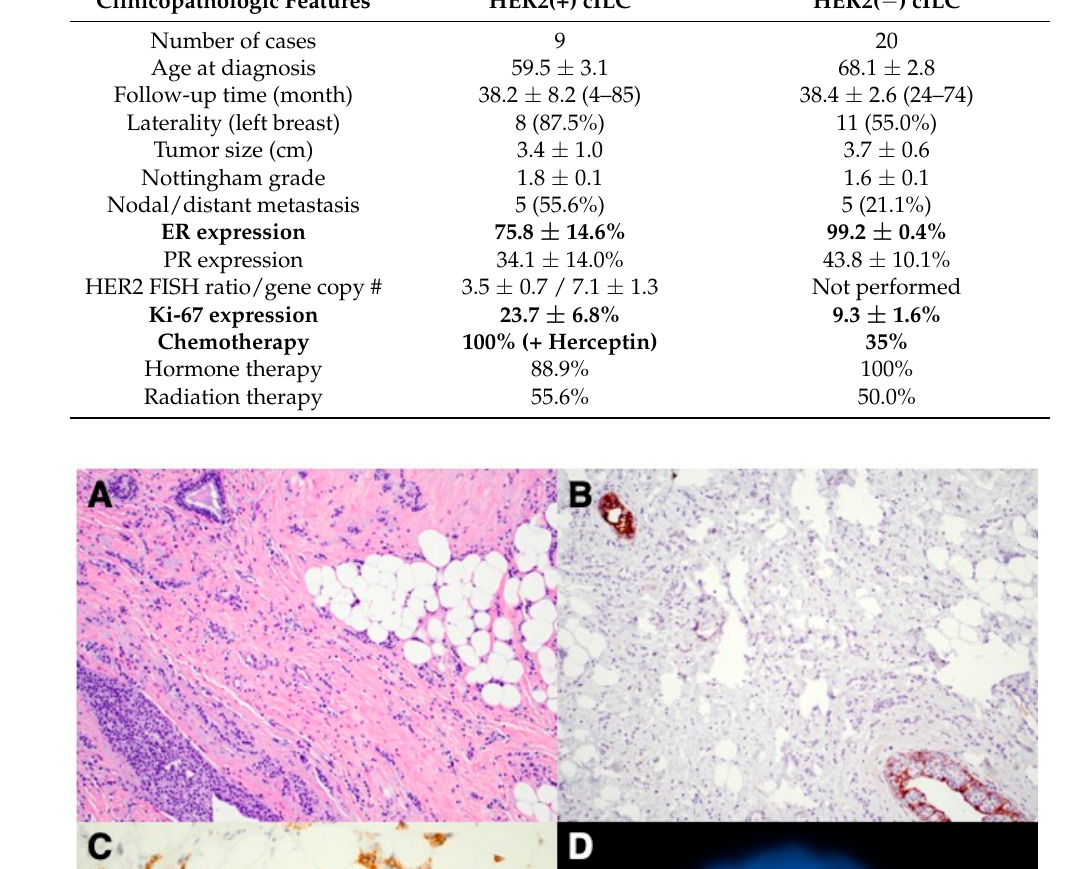
Table 1. Comparison of clinicopathologic features between HER2(+) and HER2( − ) classical type invasive lobular carcinoma (cILC) groups ( p < 0.05 highlighted in bold). Clinicopathologic Features